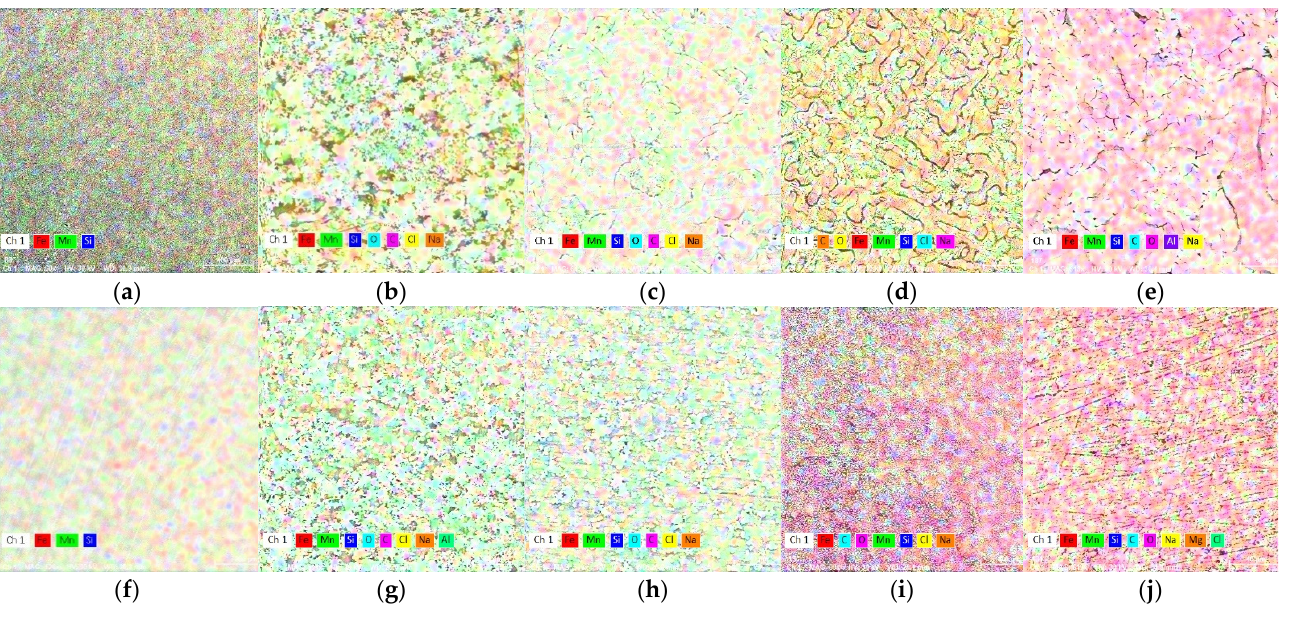
Figure 6. X-ray mapping of chemical elements on the surface. The initial samples, cast ( a ) and wrought ( f ), ( b ); C sample after 1 day immersion and ( c ) after ultrasound cleaning; ( d ) C sample after 7 days immersion and ( e ) after ultrasound cleaning; ( g ) W sample after 1 day immersion and ( h ) after ultrasound cleaning; ( i ) W sample after 7 days immersion and ( j ) after ultrasound cleaning.